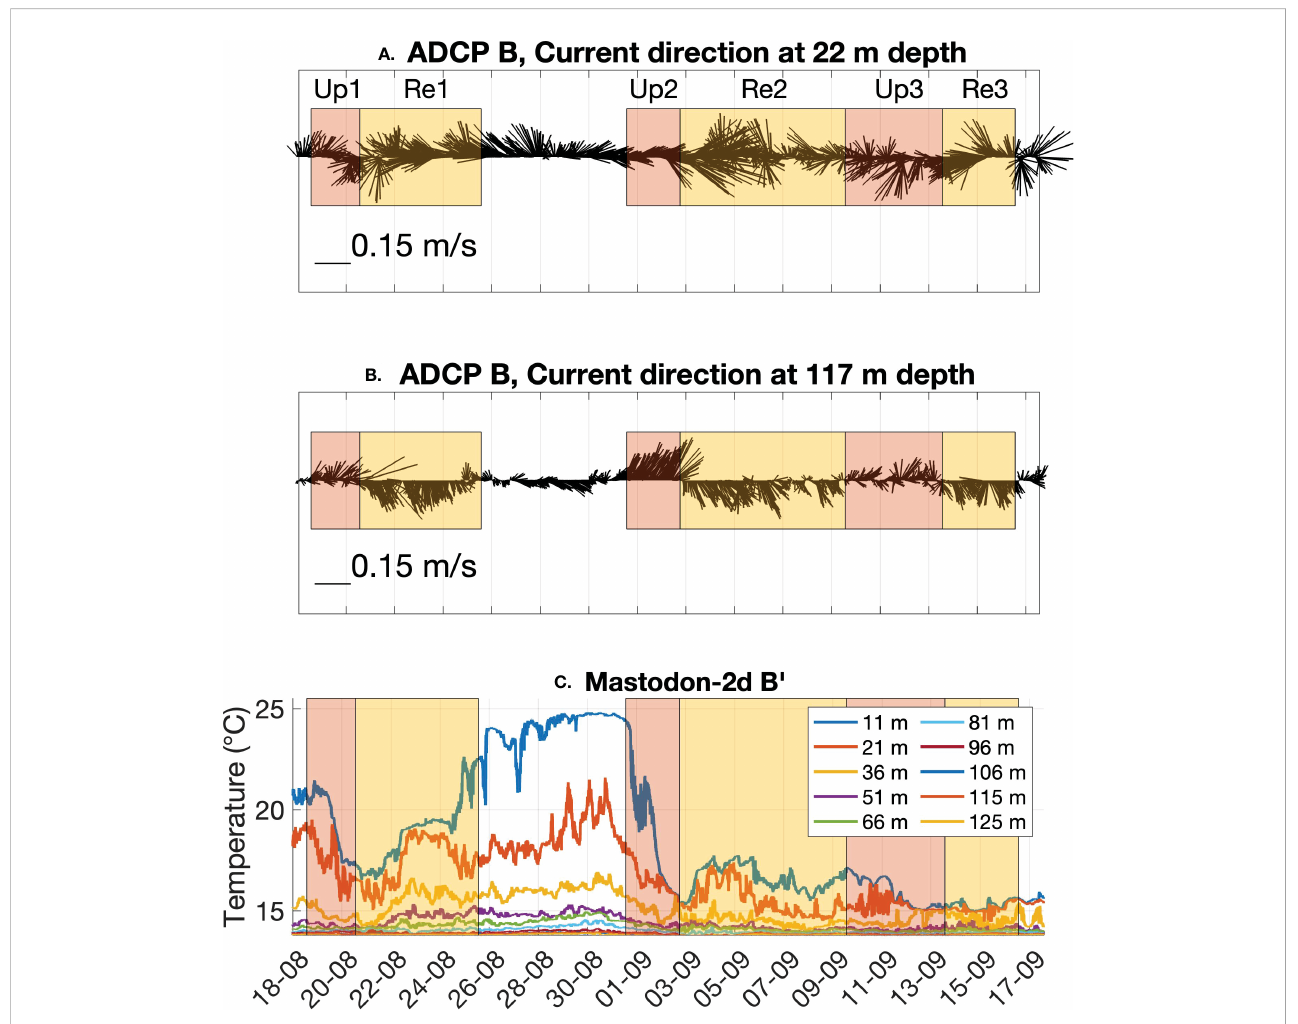
FIGURE 5 Current direction and speed measured by the ADCP B: (A) at 22 m depth and (B) at 117 m depth. The stickplots point in the direction of the current. (C) Temperature records (°C) measured by the Mastodon-2d B ’ thermistor line during the UPCAST 2017 cruise for each sensor. The red boxes ‘ Up 1 ’ , ‘ Up 2 ’ and ‘ Up 3 ’ correspond to upwelling events. The yellow boxes ‘ Re 1 ’ , ‘ Re 2 ’ and ‘ Re 3 ’ refer to the corresponding relaxation